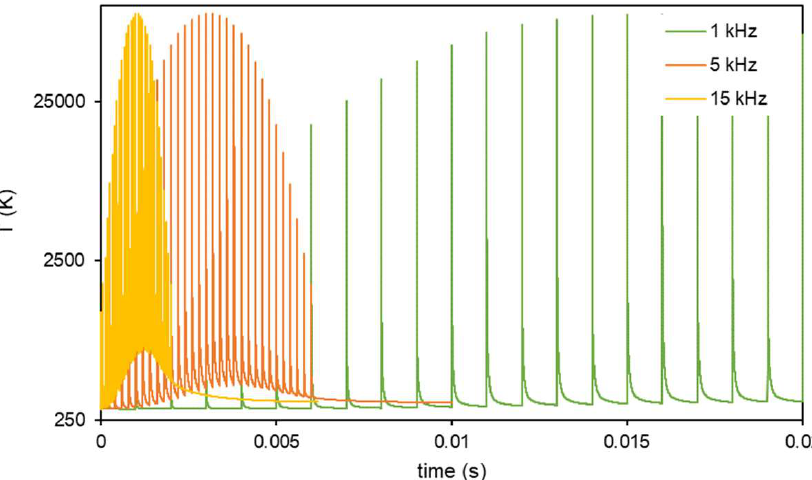
Figure 8. Steel temperature when irradiated with ps-laser pulses at different repetition rates (FEM). Only 1, 5, and 15 kHz (green, orange, and yellow series, respectively) are shown, for clarity. Cool- down temperature becomes higher with increasing repetition rate.